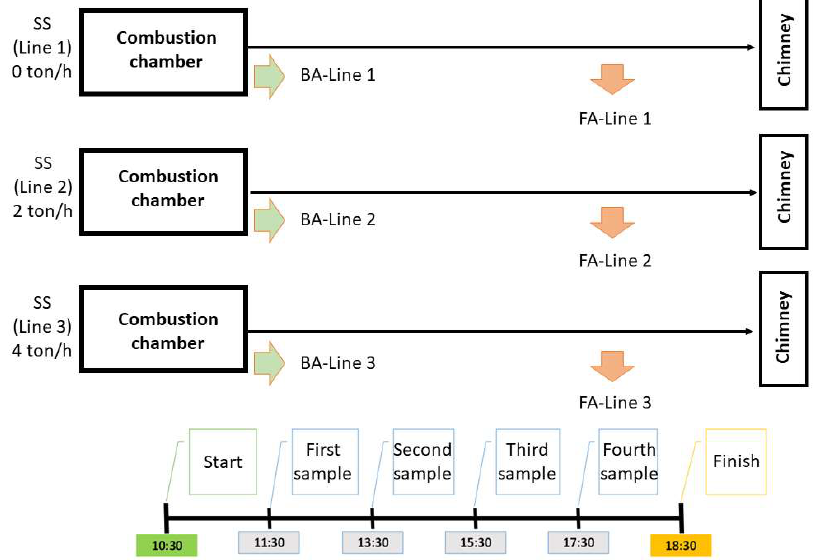
Figure 1. Schema of the co-incineration experiment made on the industrial plant, where the three different combustion lines are represented.